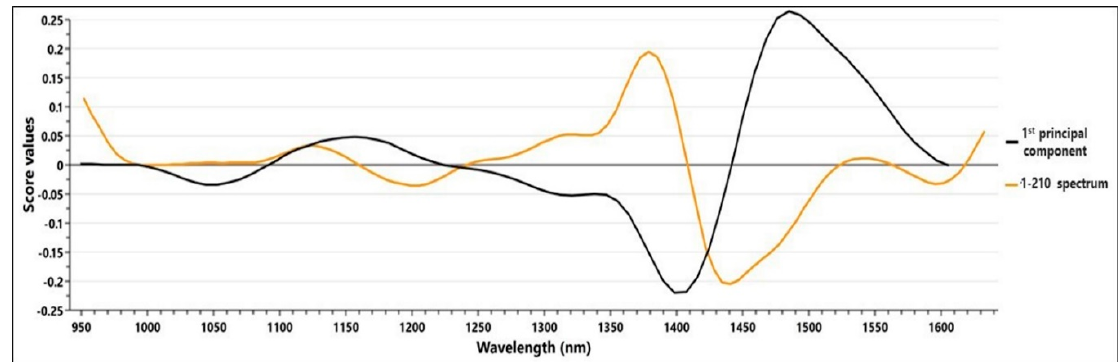
Figure 2. Loadings plot generated for the principal component analysis (PCA) model, overlapped with a preprocessed spectrum.